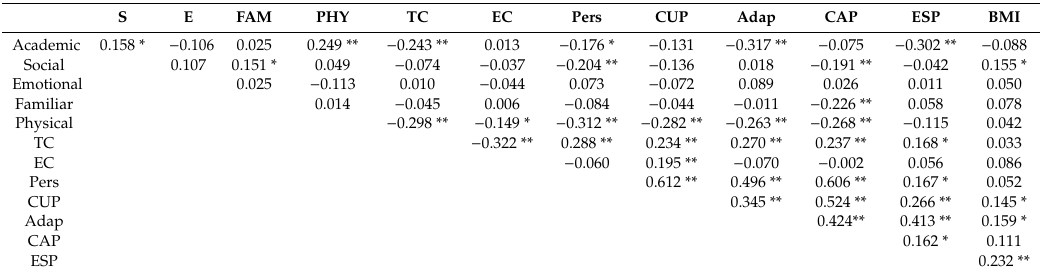
Table 3. Correlation coe ffi cients between motivational climate, self-concept levels, resilience and BMI. S E FAM PHY